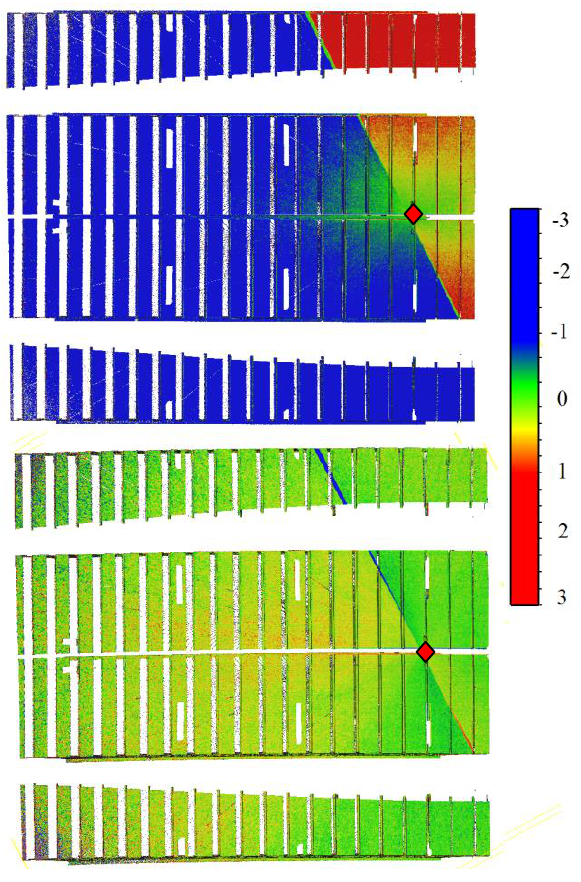
Figure 6. The M3C2 differences between the 1 st and the 2 nd scan of the roof segment, before (top) and after (bottom) the calibration (in mm). Red rhombus denotes the scanner station